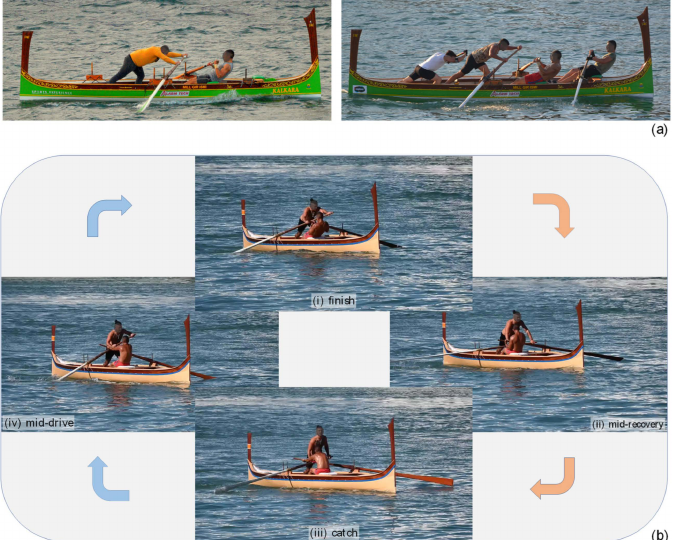
Figure 1. The basics of Venetian style standing rowing, demonstrated here on the Maltese “ Dg ¯ hajsa tal-Pass ” racing traditional rowing boat where the standing rower is shown alongside a seated rowing. ( a ) A shows the “finish” position for the boat set up with a crew of two ( left ) or four ( right ) rowers whilst ( b ) highlights the key components of the cycle, where a standing rower (locally known as the “ parasija